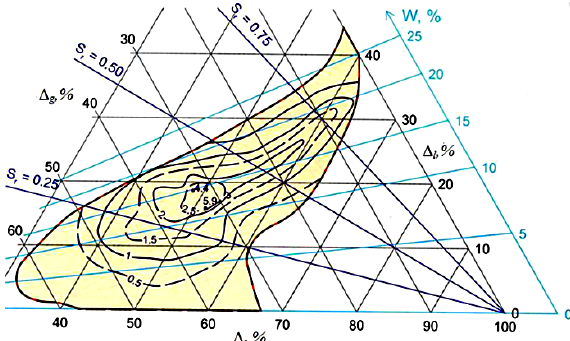
Fig. 6. The diagram of moisture redistribution speed values of V ·10 –6 , cm/s in 4 hours from the experience beginning depending on sand phase composition